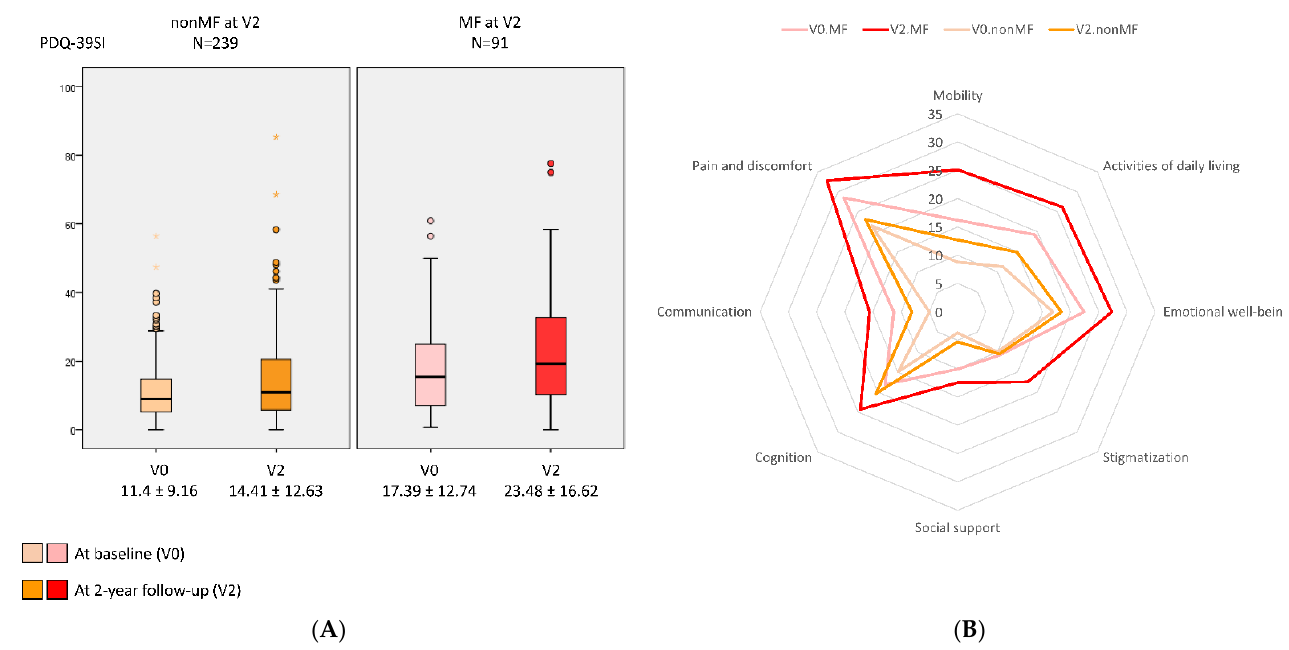
Figure 3. ( A ) QoL (PDQ-39SI) ( y -axis) at baseline (V0) and after a 2-year follow-up (V2) ( x -axis) in PD patients who developed MF at V2 (MF at V2 (PD-MFV2); N = 91) and those patients who did not developed MF at V2 (nonMF at V2 (PD-nonMFV2); N = 239). PDQ-39SI at V0, PD-MF V2 vs. PD-nonMF V2 , p < 0.0001; PDQ-39SI at V2, PD-MF V2 vs. PD-nonMF V2 , p < 0.0001; change in the PDQ-39SI from V0 to V2 in PD-MF V2 , p < 0.0001; change in the PDQ-39SI from V0 to V2 in PD-nonMF V2 , p < 0.0001; comparison between the change in the PDQ-39SI from V0 to V2 in PD-MF V2 vs. PD-nonMF V2 , p = 0.005. ( B ) Mean score on each domain of the PDQ-39SI at V0 and at V2 in both groups, PD-MF V2 and PD-nonMF V2 . At V0, the difference was significant between both groups in all domains ( p values from 0.023 to <0.0001) except in PDQ-39SI-4 (Stigmatization) ( p = 0.169) and PDQ-39SI-6 (Cognition) ( p = 0.097). At V2, the difference was significant between both groups in all domains ( p values from 0.005 to <0.0001) except in PDQ-39SI-6 (Cognition) ( p = 0.319). PDQ-39 is expressed as a Summary Index (PDQ-39SI). Data are presented as box plots, with the box representing the median and the two middle quartiles (25–75%). p values were computed using the Kolmogorov–Smirnov, Mann– Whitney, and Wilcoxon tests. Mild outliers (O) are data points that are more extreme than Q1 − 1.5 * IQR or Q3 + 1.5 * IQR.